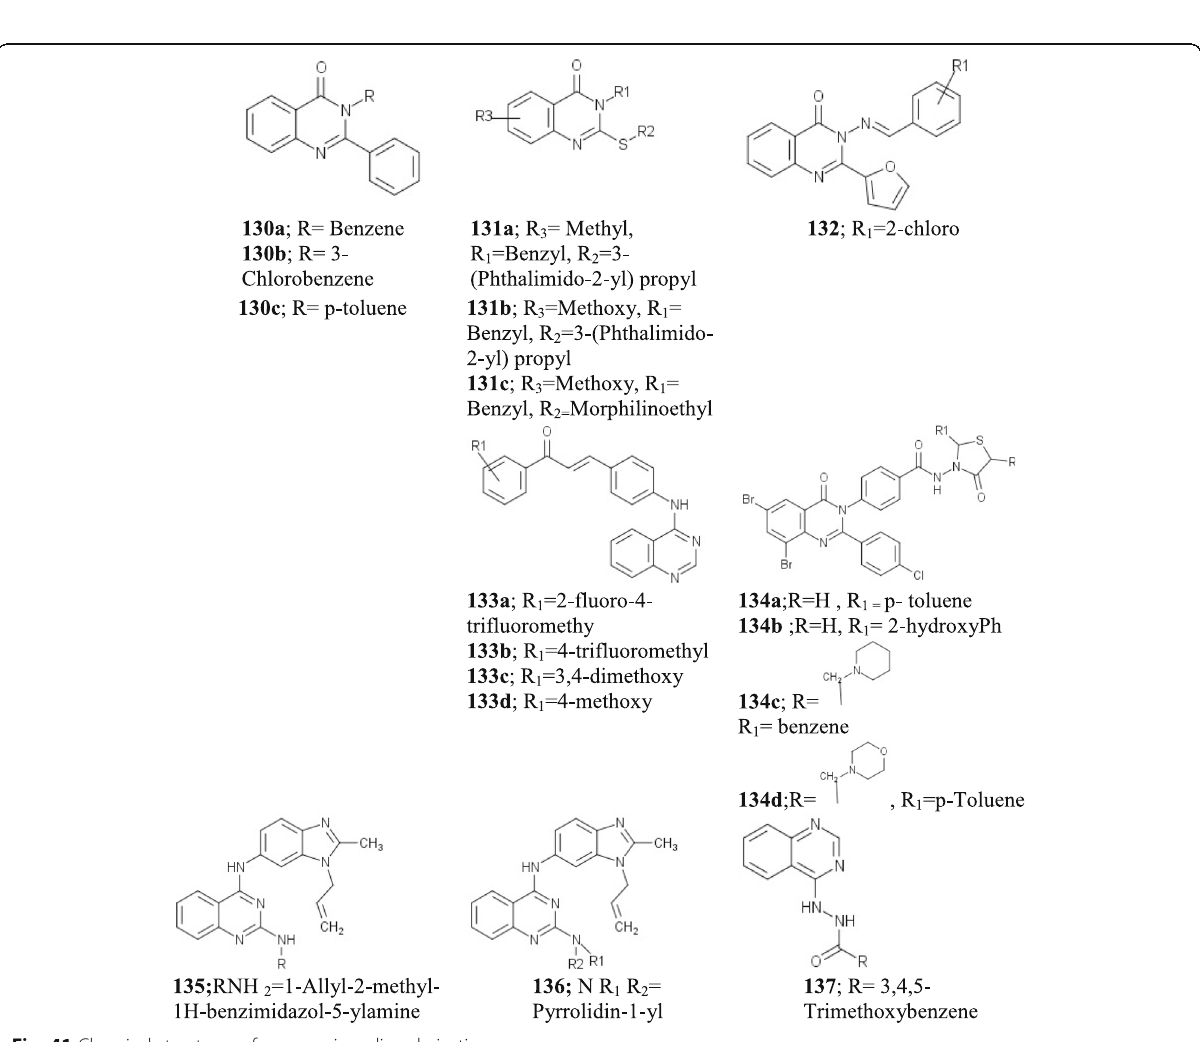
Fig. 41 Chemical structures of some quinazoline